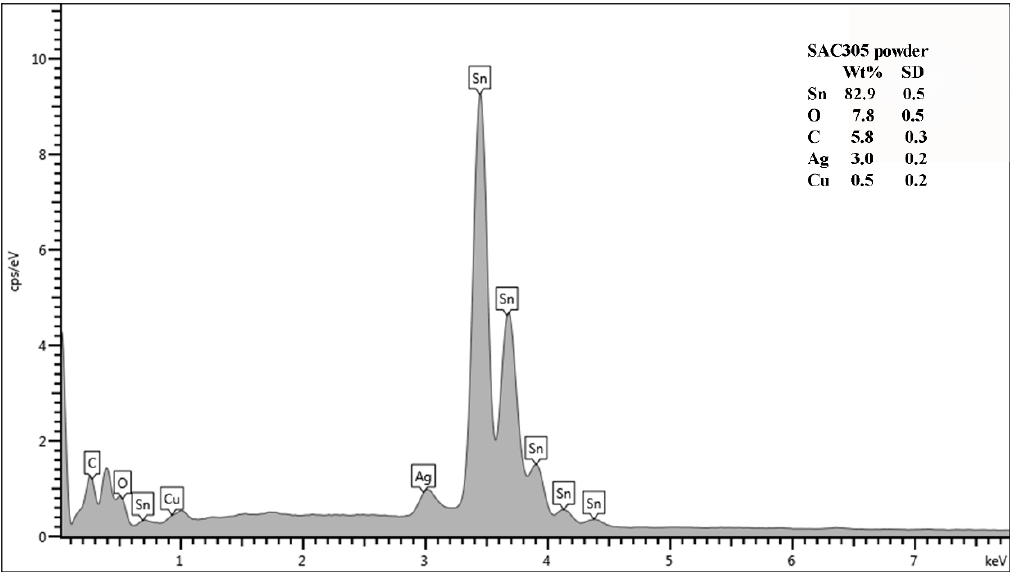
Figure 12. EDS (Energy Dispersive Spectroscopy) spectrum of SAC305 lead-free solder fine powder product.